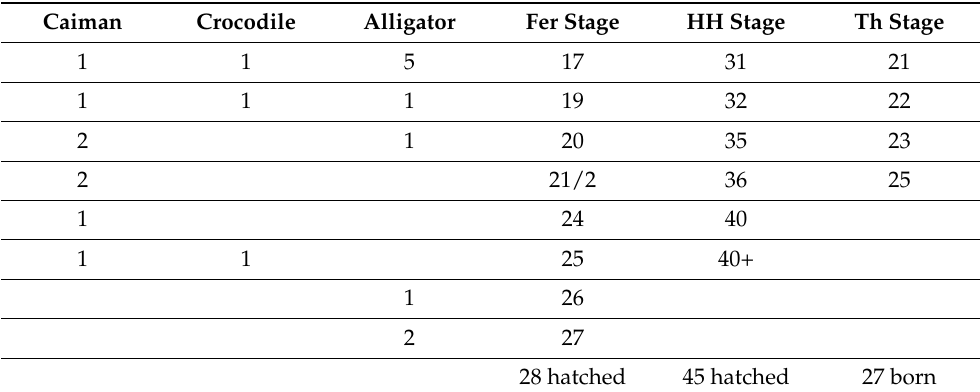
Table 1. Number of embryos and stages used. Fer Ferguson stage (crocodilians), compared with HH Hamburger and Hamilton stage (chicken), and Th Teiler stage